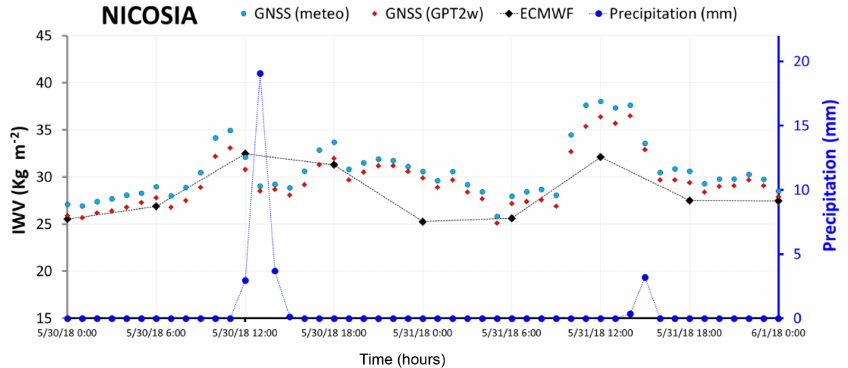
Figure 6. Variations of IWV and Precipitation (dark blue dots) over Nicosia station during 30 and 31 May 2018. Light blue dotted line represents the GNSS-derived IWV by using in situ meteorological observations. A red dotted line corresponds to GNSS-derived IWV by using GPT2w model and black dotted line is the IWV calculated from ECMWF